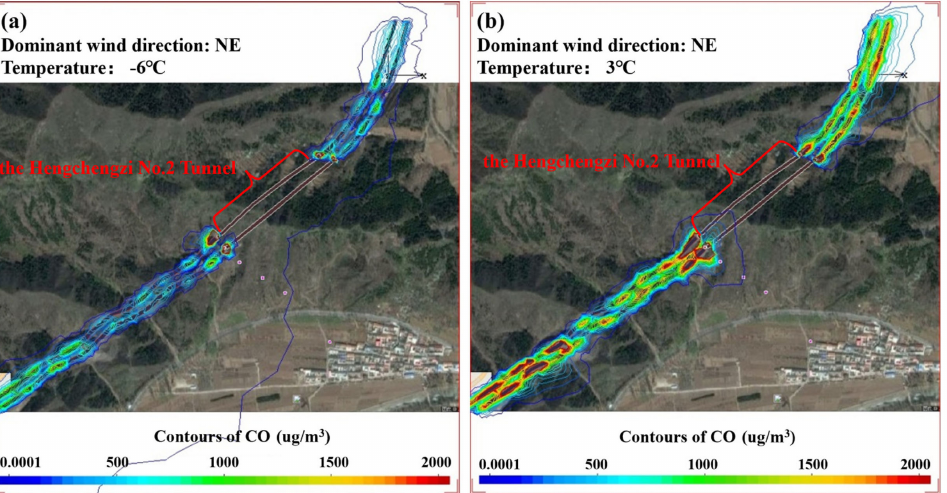
Figure 16. Average concentration distribution of CO in the Hengchengzi No. 2 Tunnel section. ( a ) Low temperature ( − 6 ◦ C); ( b ) High temperature (3 ◦